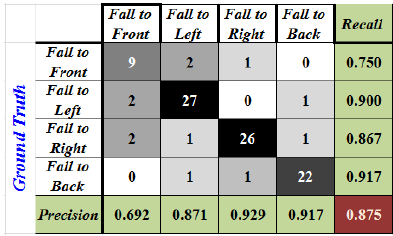
Figure 15: Confusion Matrix of DTW based k NN